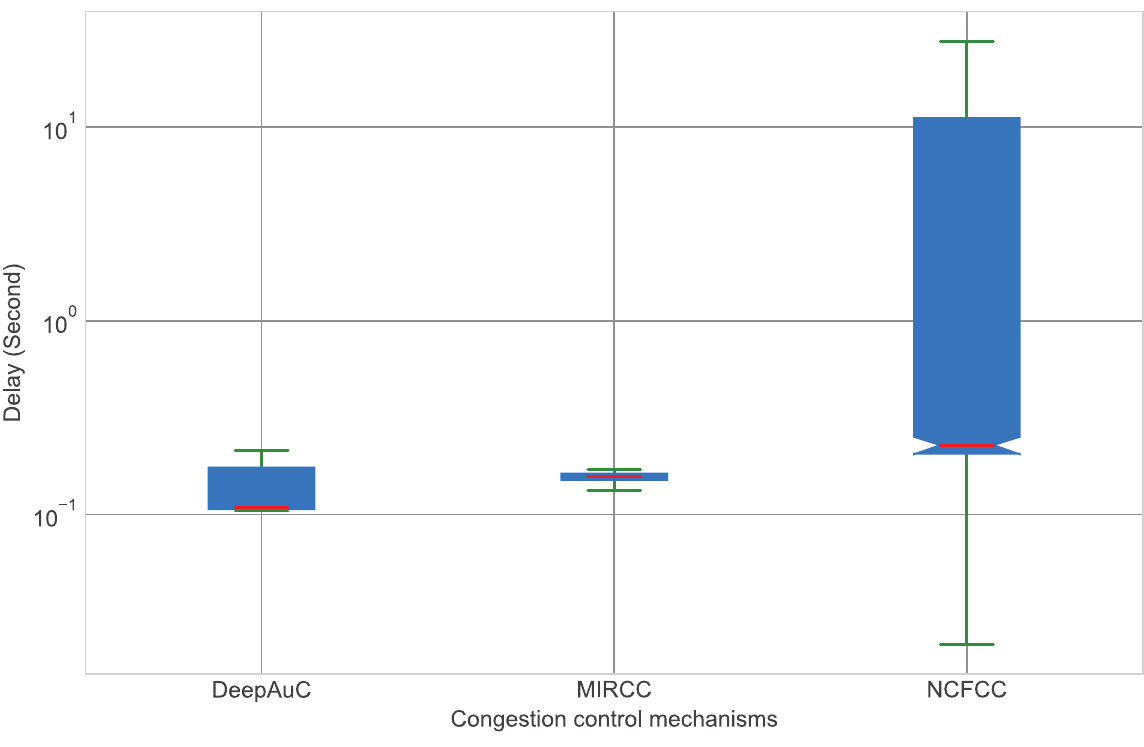
Fig 9. Comparison of the network